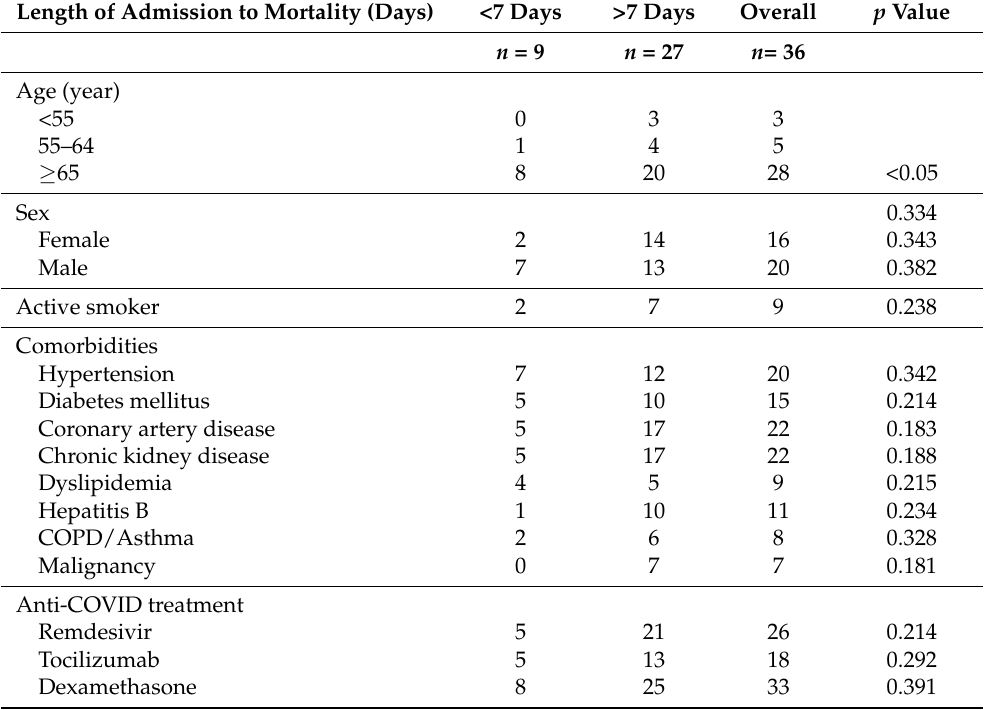
Table 1. Demographics, baseline characteristics, and treatment of the patients with COVID-19